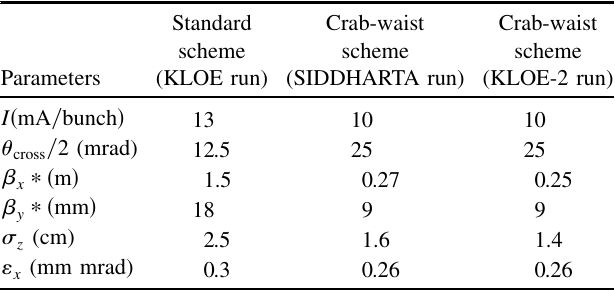
MONTE CARLO SIMULATION FOR THE TOUSCHEK . . TABLE II. Comparison of main beam parameters for KLOE (2006), SIDDHARTA (2008–2009), and present KLOE-2 runs for luminosity and lifetime and backgrounds.